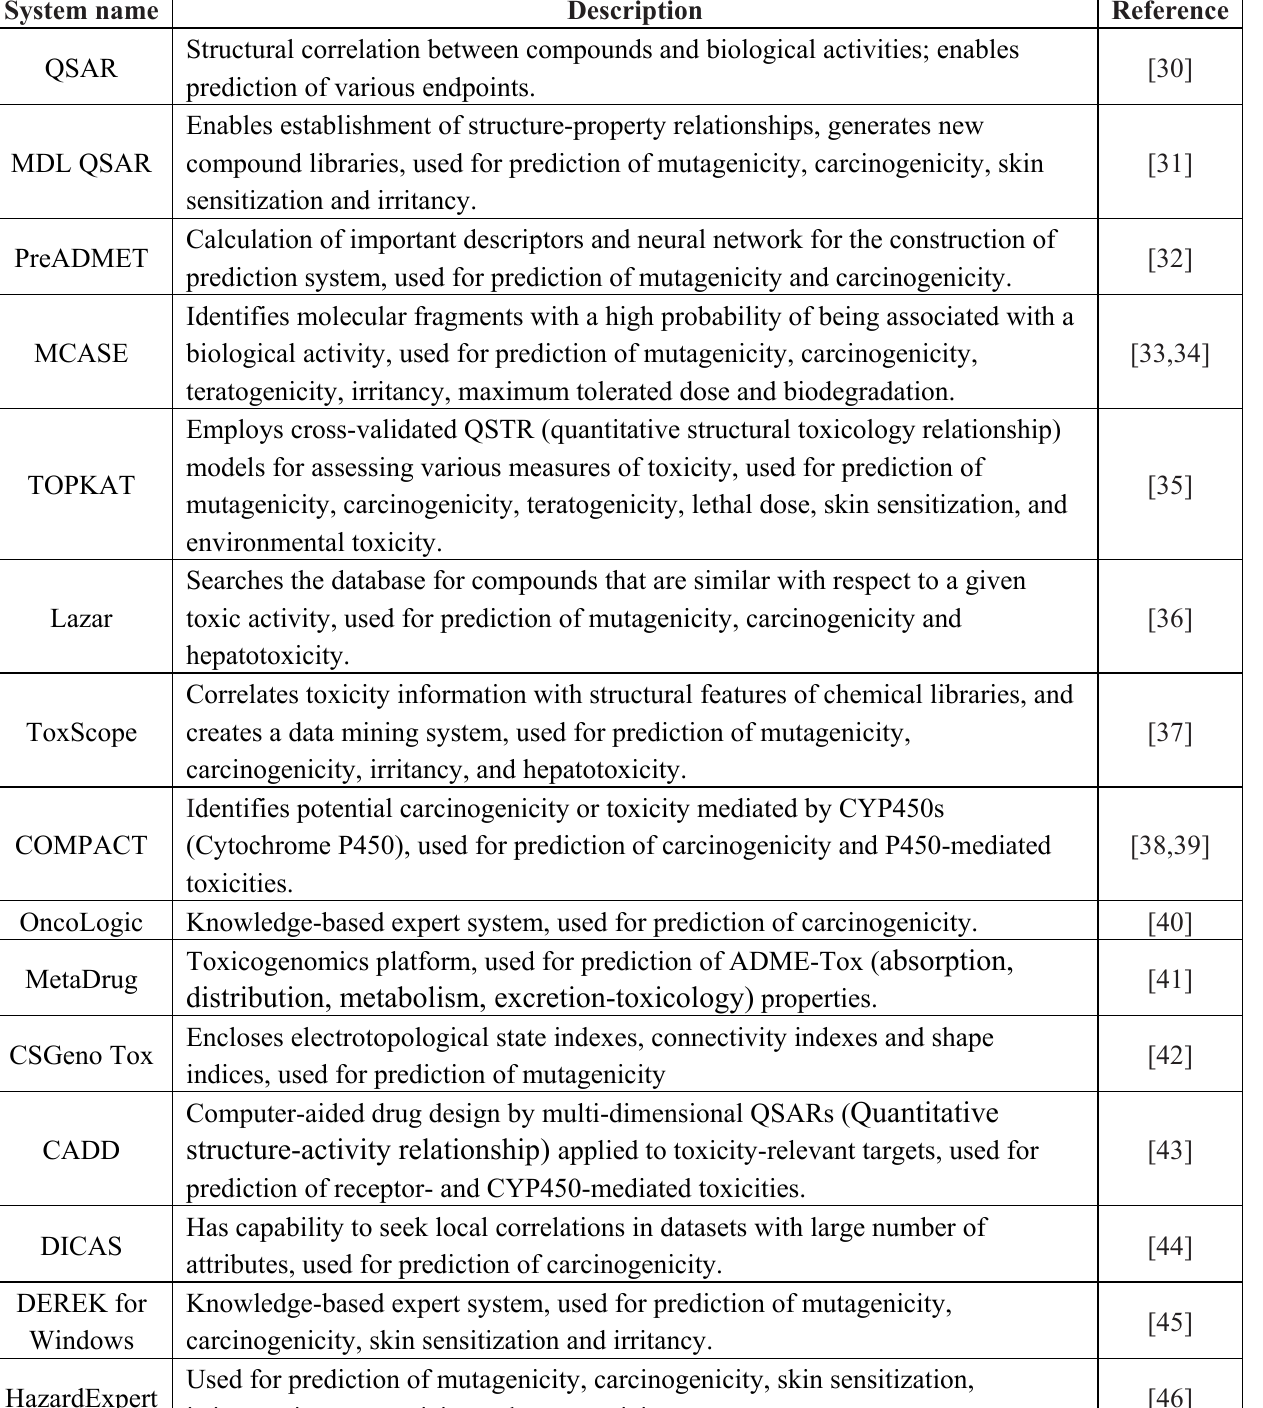
Table 1. Examples of available in silico